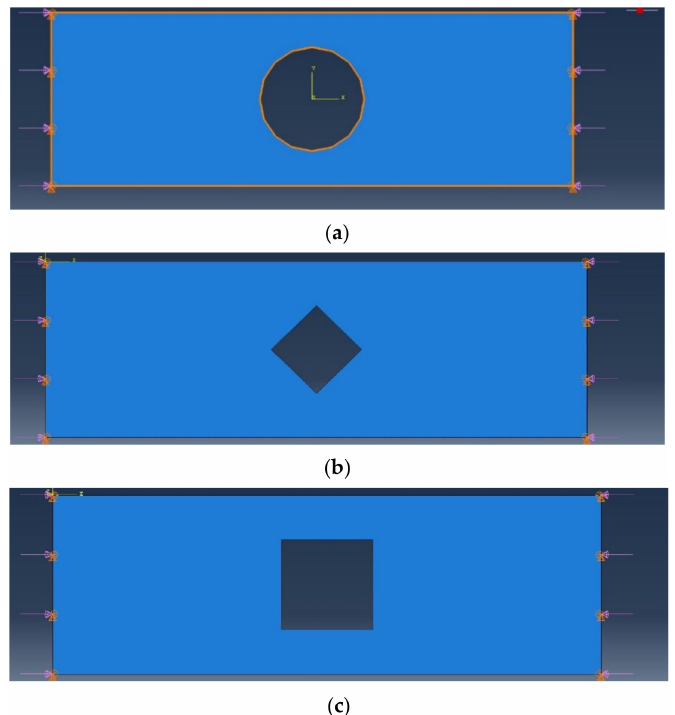
Figure 7. The model and boundary conditions of the FGM plate with ( a ) circle, ( b ) diamond, and ( c ) square opening.